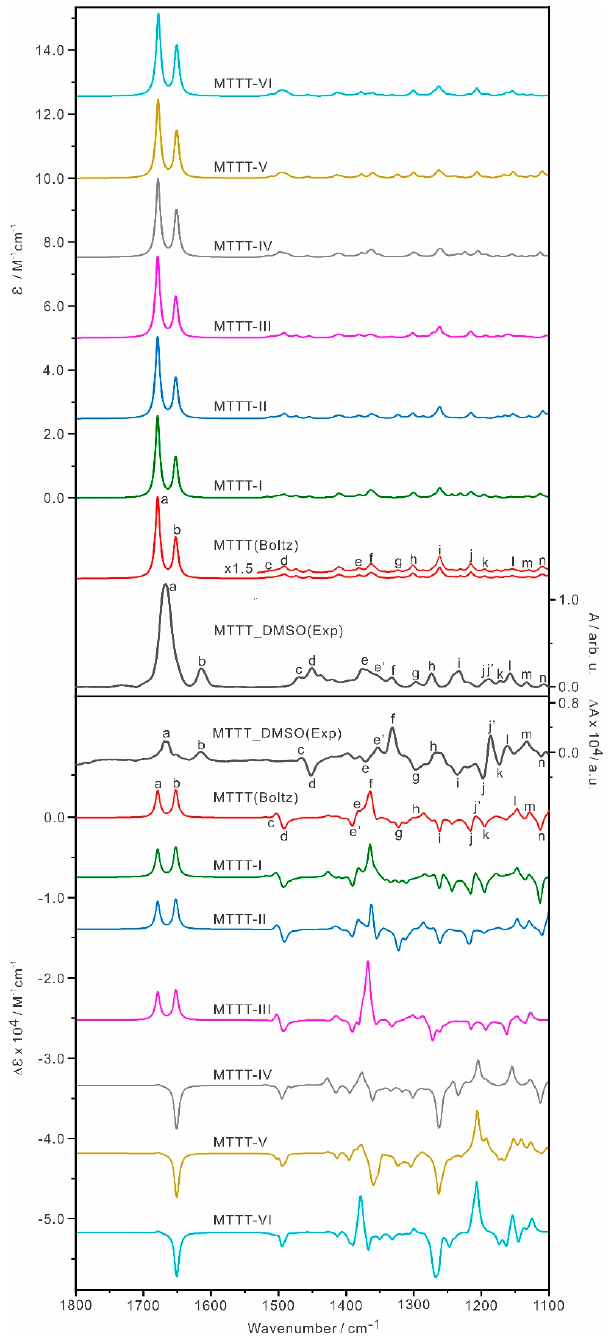
Figure 4. Simulated IR and VCD spectra of the six most stable MTTT conformers, MTTT − I to − VI and the related Boltzmann averaged IR and VCD spectra at the B3LYP − D3BJ/def2 − TZVPD/PCM(DMSO) level of theory at 298 K. The experimental units are on the right side. The main IR and VCD band features are labelled as ‘a’ to ‘n’ to aid the comparison. In the above 1600 cm − 1 region, a positive VCD band, labelled as ‘c’, was observed for the C=C stretch, similar to that in the related MTTT, and was correctly predicted. In addition, a tiny positive VCD band, labelled as ‘a’, was predicted for the acetyl C=O band.